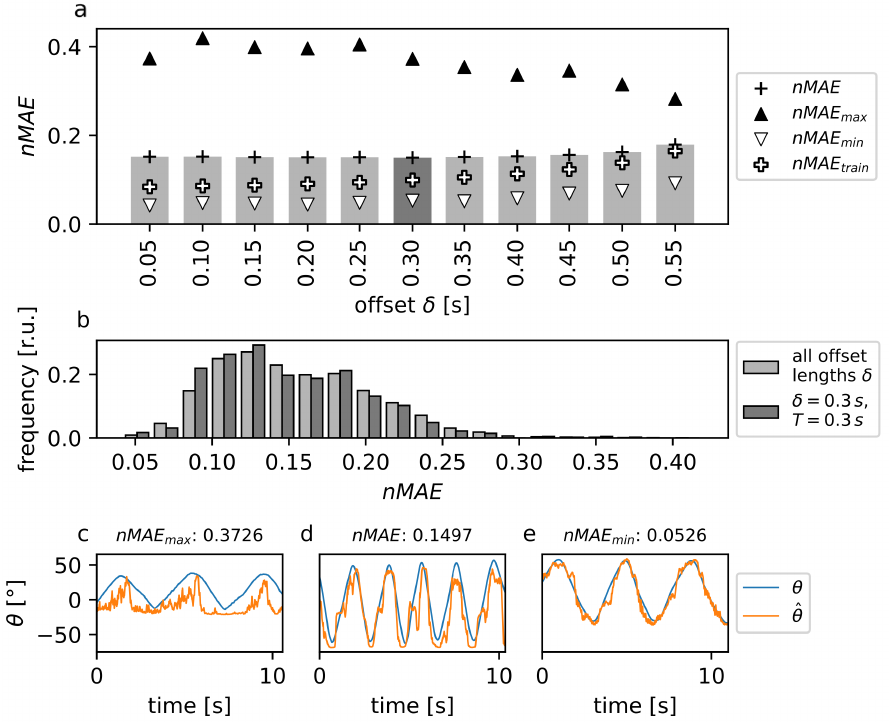
Figure 7. Average prediction performance of FFNN models trained with different offsets δ and segment length T corresponding to a shift of the segment boundary T end using the IEMG feature and an overlap corresponding to a 100Hz feature signal frequency. ( a ) Mean absolute errors for elbow motion prediction based on different offsets δ = [0.05 s. . . 0.55s] and corresponding segment lengths T = [0.55s. . . 0.05s] with a step size of 0.05s. The different symbols depict the prediction error ( nMAE ) using the test data set ( black plus sign ), the corresponding minimum ( nMAE min ; white arrow ) and maximum ( nMAE max ; black arrow ) prediction errors, as well as the prediction errors for the training data set ( nMAE train ; white plus sign ). ( b ) Normalized frequency distribution of prediction errors using the IEMG feature for all offsets δ and corresponding segment lengths T (light gray bars) and an offset of ( δ =) 0.3s and a segment length of ( T =) 0.3s (dark gray bars), which yielded the highest prediction accuracy ( dark gray color in ( a ) ). ( c – e ) Exemplary plots of an experimentally recorded elbow-joint angle θ ( blue ) and the corresponding model prediction ˆ θ ( orange ) based on the IEMG feature with an offset of ( δ =) 0.3s and a segment length of ( T =) 0.3s: ( c ) prediction with the highest prediction error ( nMAE max = 0.3726), ( d ) model prediction closest to the mean prediction error ( nMAE = 0.1497) and ( e ) model prediction with the lowest prediction error ( nMAE min =